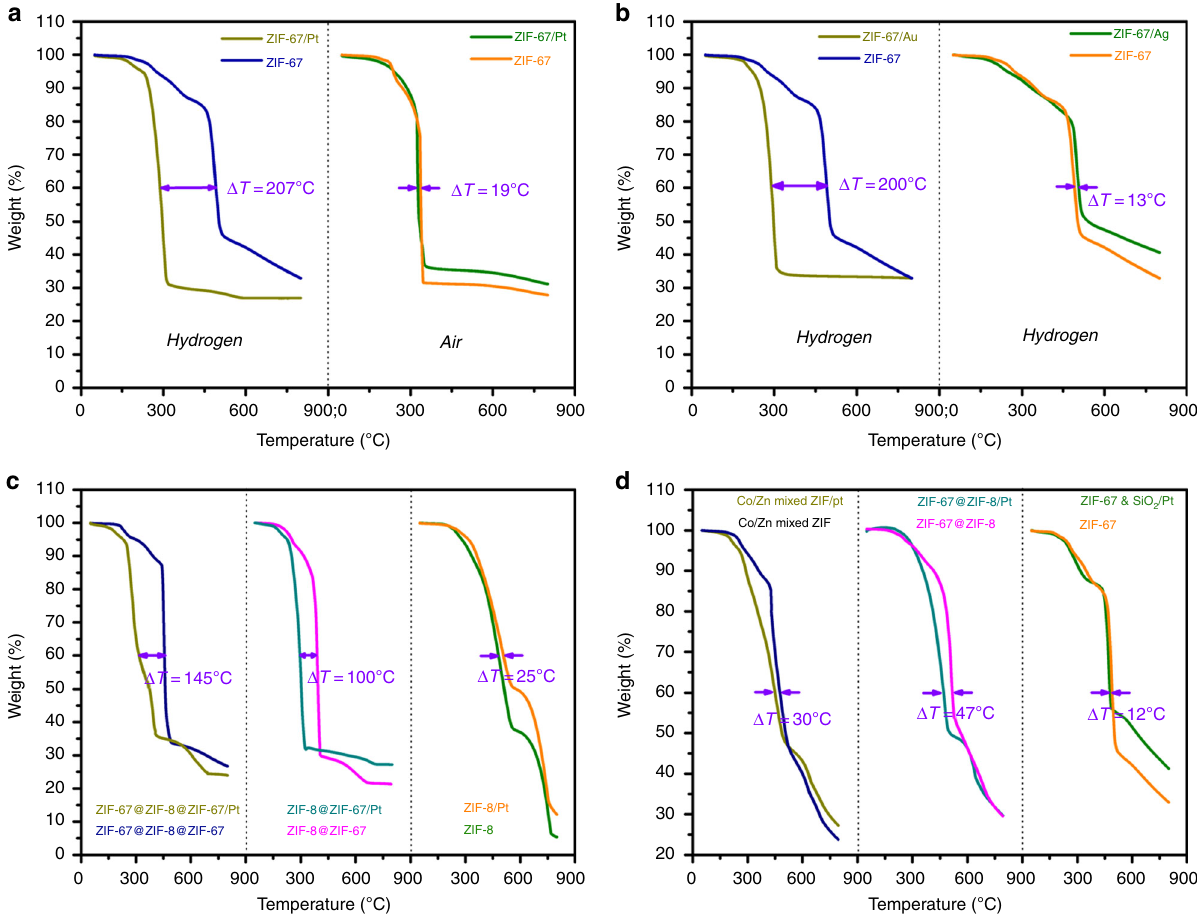
Fig. 7 Comparisons of T w60 in different ZIFs and composites. a ZIF-67 with or without Pt loading in different atmospheres, b ZIF-67 loading with different metals under fl owing H 2 (H 2 % = 4.2% in N 2 ), c ZIF-67@ZIF-8@ZIF-67, ZIF-8@ZIF-67 and ZIF-8 with or without Pt loading under fl owing H 2 (H 2 % = 4.2% in N 2 ), and d Co/Zn mixed ZIF and ZIF-67@ZIF-8 with or without Pt loading and ZIF-67/(SiO 2 /Pt) mixture under fl owing H 2 (H 2 % = 4.2% in N 2 ).